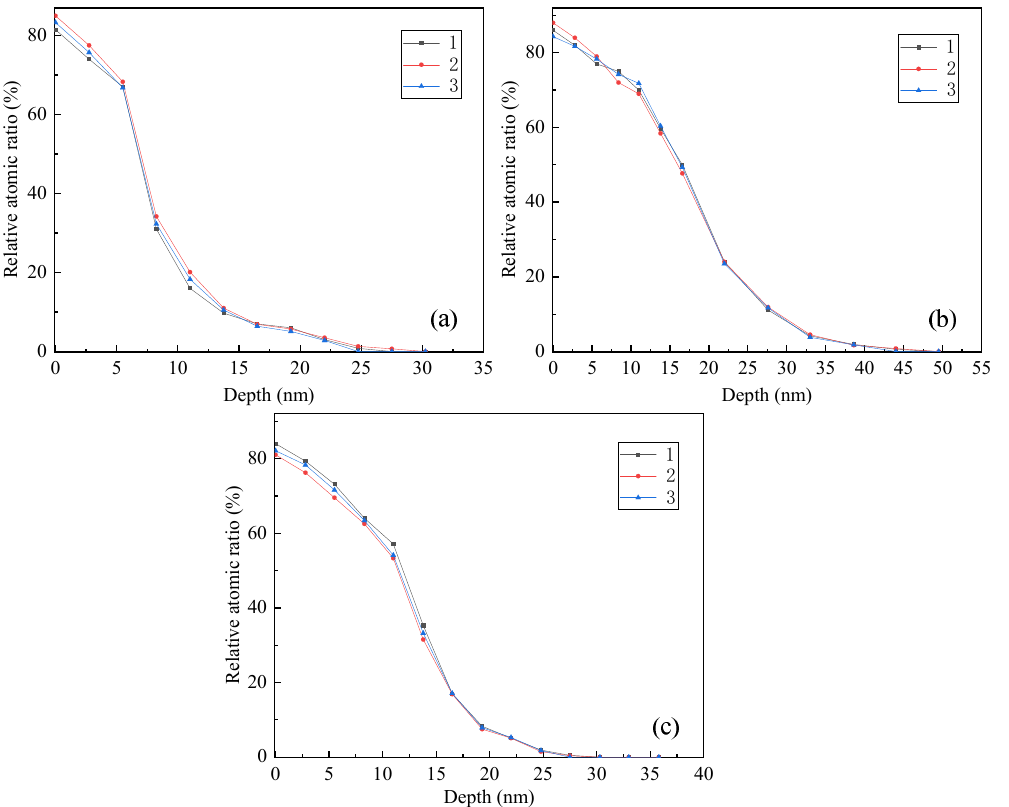
Figure 4. XRD patterns of electrochemical polishing surface.